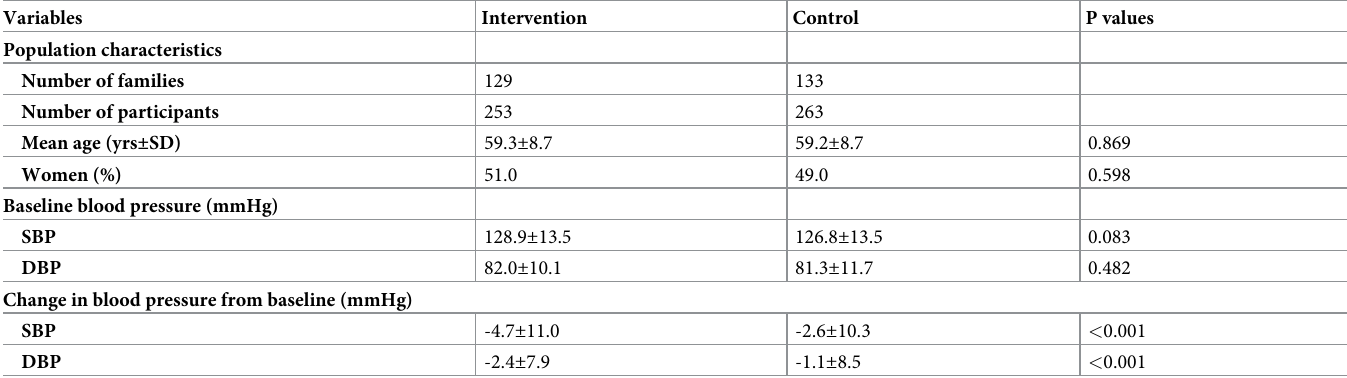
Table 2. Characteristics of the study population and the pre-and-post-intervention changes in systolic (SBP) and diastolic blood pressure (DBP) in the randomized salt substitute trial, by intervention group.